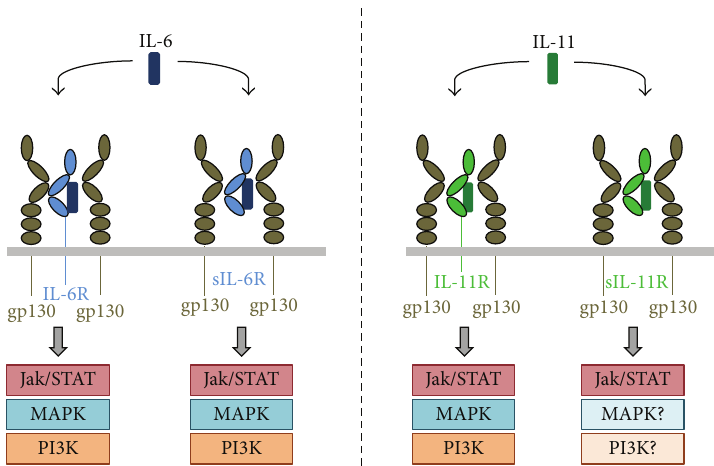
Figure 1: Schematic illustration of IL-6 and IL-11 signaling. IL-6 (dark blue) binds to membrane-bound and soluble forms of the IL-6R (light blue), which leads to gp130 (brown) homodimerization and subsequent activation of the intracellular signaling pathways Jak/STAT, MAPK, and PI3K. Similarly, IL-11 (dark green) can bind to both membrane-bound and soluble forms of the IL-11R (light green), and both lead to homodimerization of gp130. Whereas activation of Jak/STAT, MAPK, and PI3K has been shown for signaling via the membrane-bound IL-11R, formally only activation of the Jak/STAT pathway via the sIL-11R has been